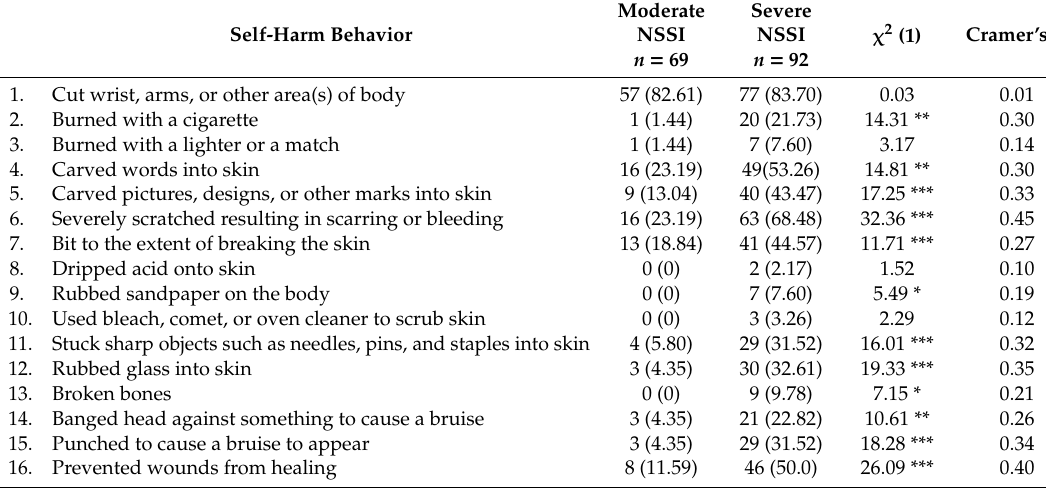
Table 2. Frequency and percentage of Deliberate Self-Harm Inventory (DSHI) items engaged in by the two non-suicidal self-injury groups ( n = 161).